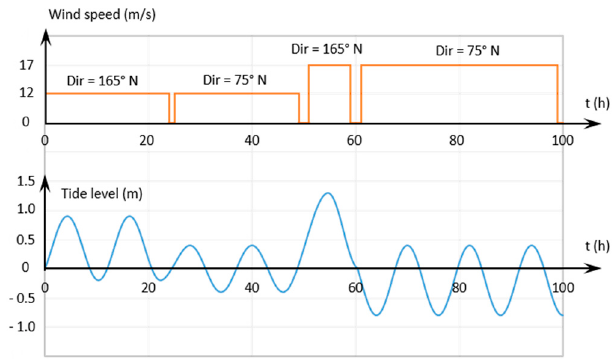
Figure 11. Reconstructed tidal oscillation, comprehensive of the meteorological component associated with the sequence of winds representative of an average year.